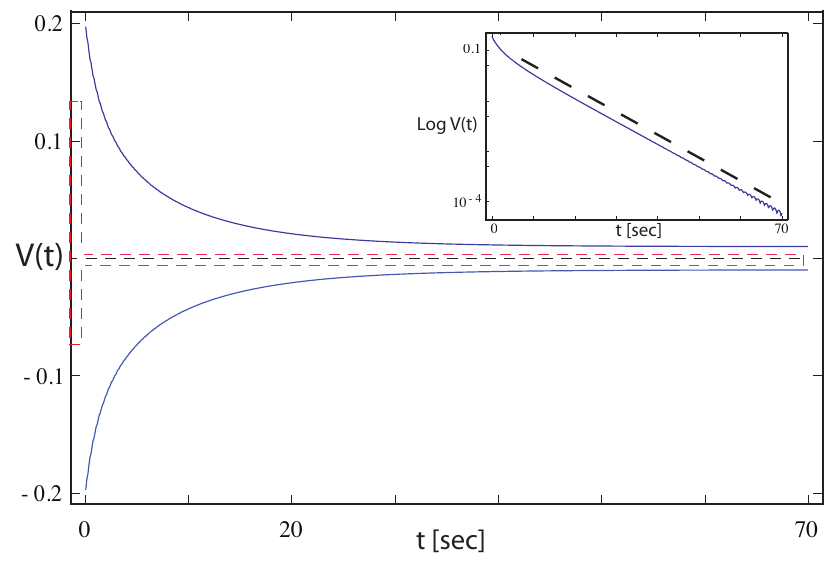
Figure 4. Blue: Envelope of the exponential decay from larger towards smaller stimulation according to Equation (5), using the same temporal units as in [1]. Red: Results from the device (according to Figure 5(b) in [1]). The asymmetric response and the substantial decay mismatch indicate that Equation (5) does not provide an accurate description of the electronic device.